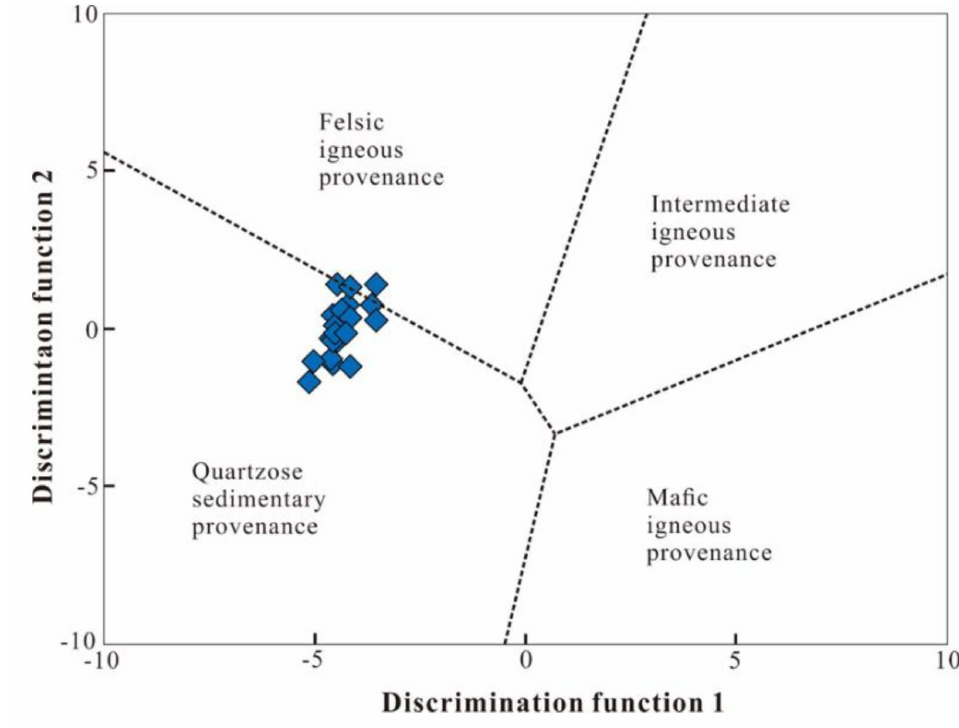
Figure 7. Provenance discriminant function using major elements [38]. 13. DF1 = − 1.772TiO 2 + 0.607Al 2 O 3 + 0.76Fe 2 O 3T − 1.5MgO + 0.616CaO + 0.509Na 2 O − 1.224K 2 O − 9.09; DF2 = 0.445TiO 2 + 0.07Al 2 O 3 − 0.25Fe 2 O 3T − 1.142MgO + 0.438CaO + 1.475Na 2 O + 1.426K 2 O −